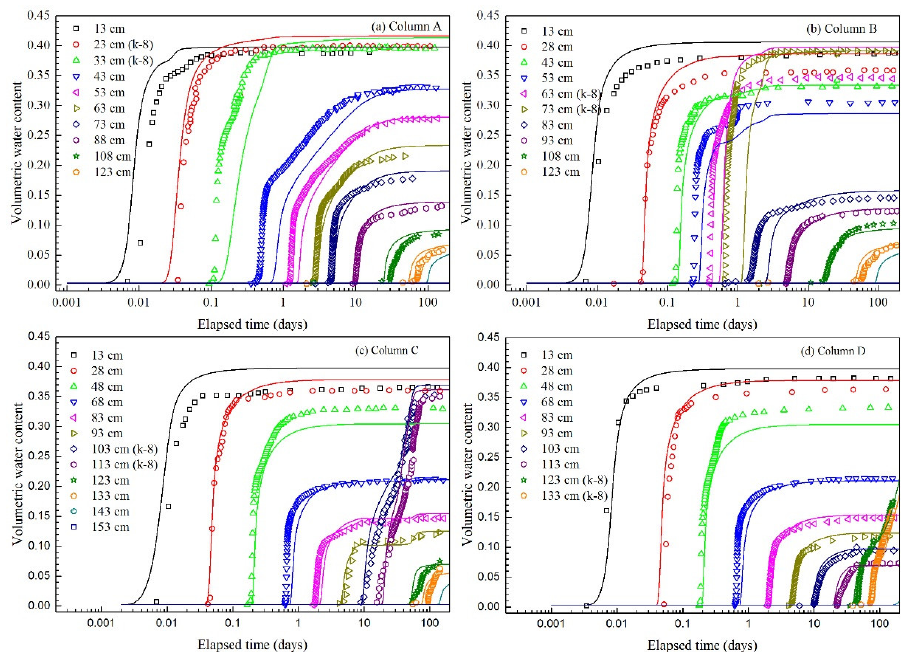
Figure 7. Comparison of the water content distribution in the layered soil profiles obtained by the test and the numerical simulation.